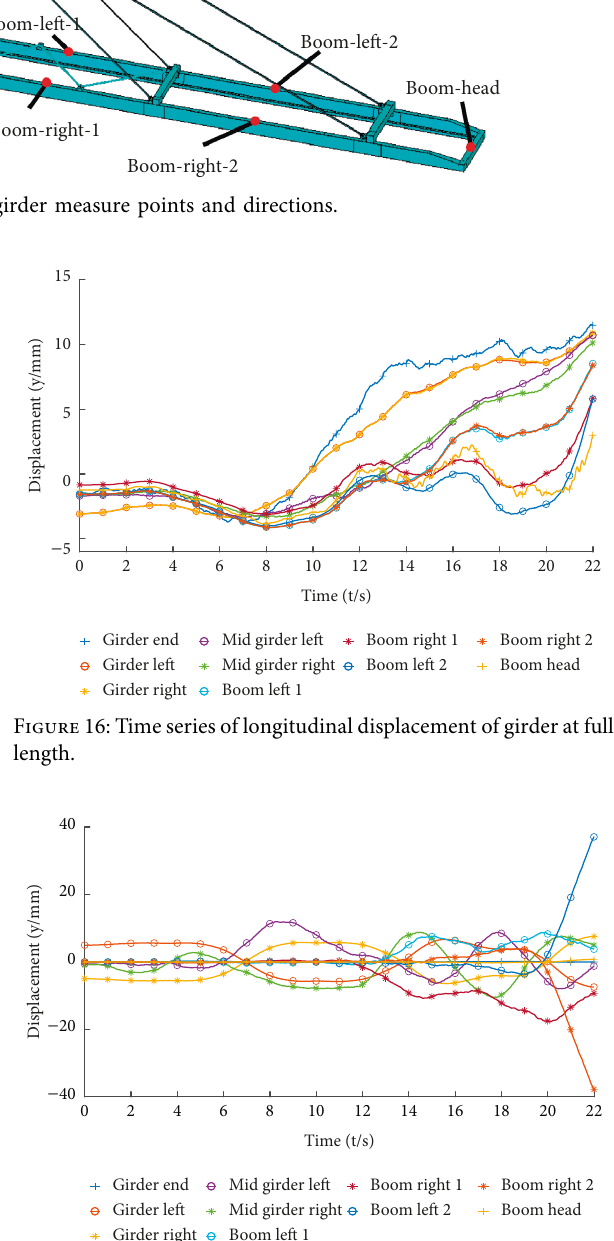
Figure 17: Time history of lateral displacement of girder at full